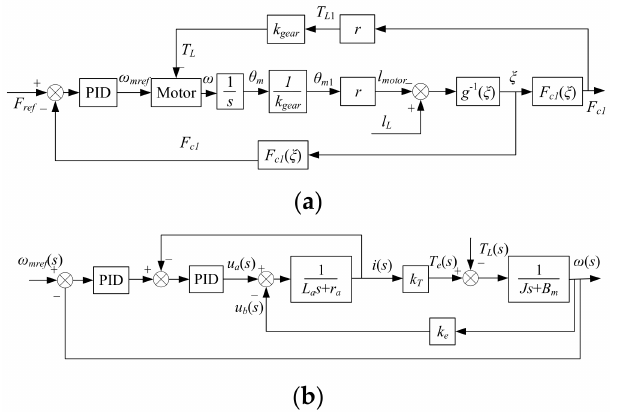
Figure 10. Tension control block diagram. ( a ) Cascade controller of the nonlinear cable SEA. ( b ) Motor control block